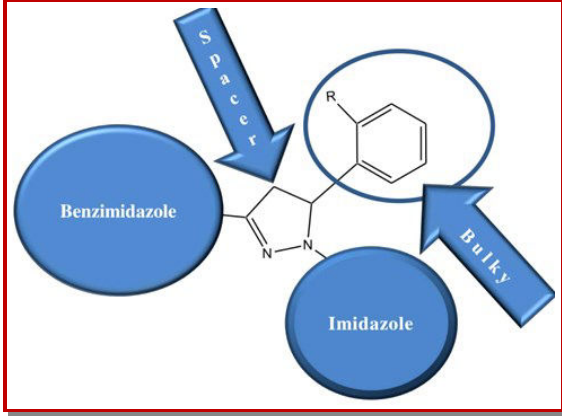
Figure 1: Pictorial representation of molecule with spacer and bulky